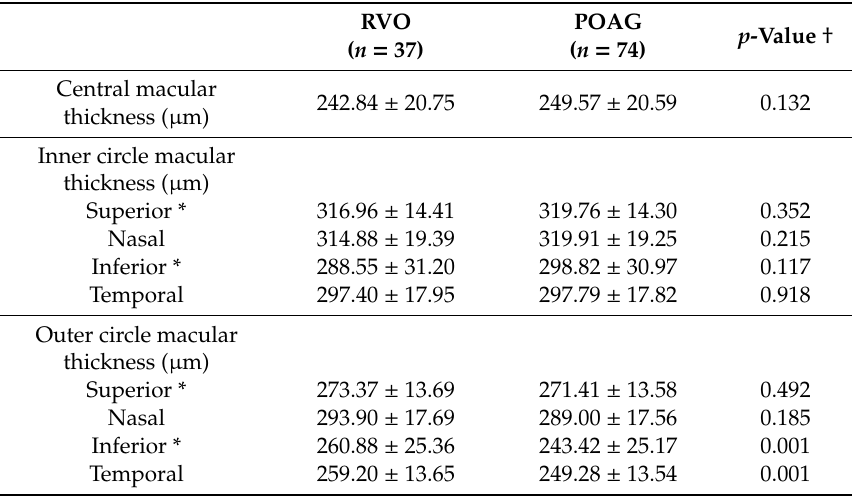
Table 3. Comparison of the overall macular thickness in patients with retinal vein occlusion and primary open-angle